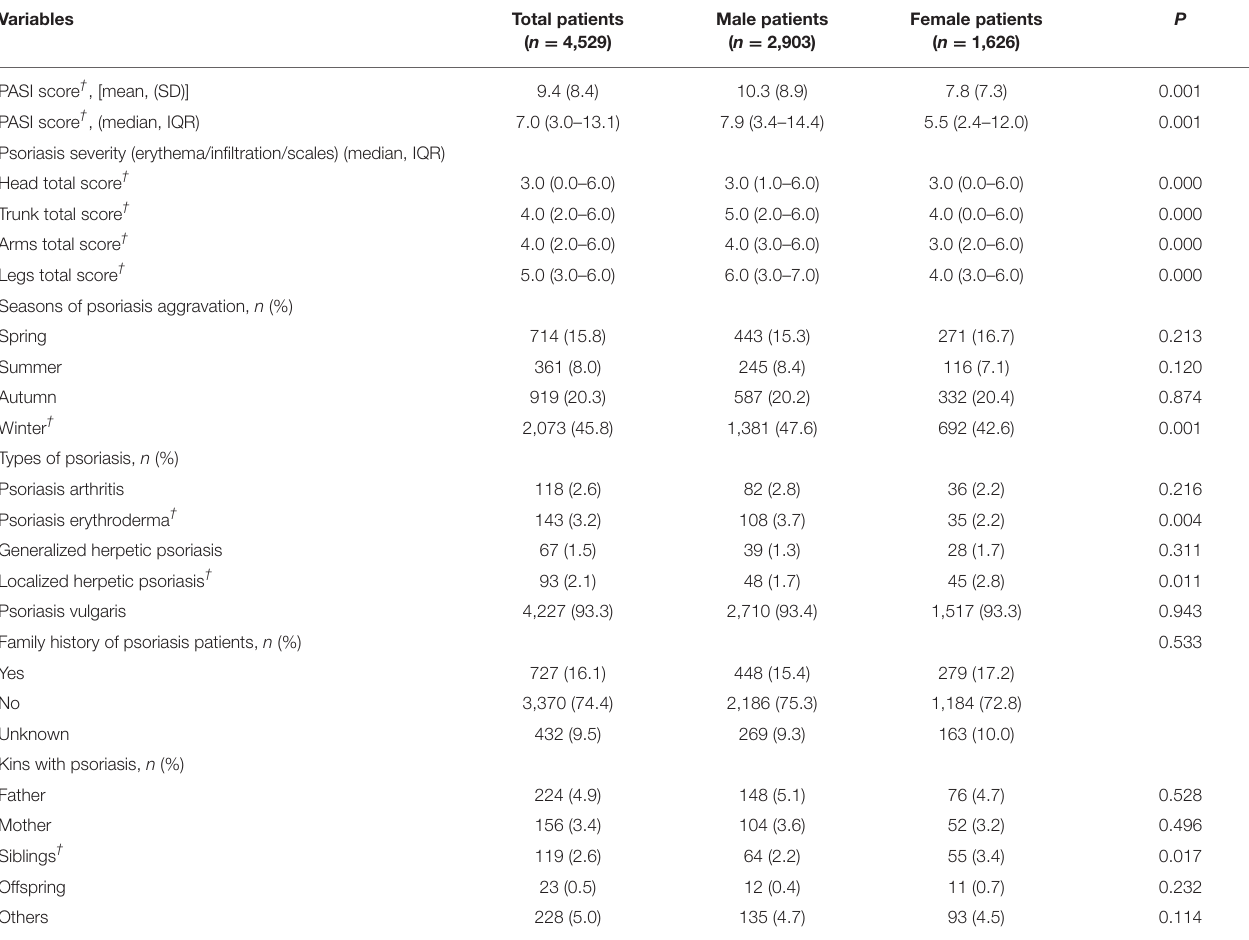
TABLE 3 | The psoriasis severity, family history, seasonality aggravation and skin damage condition among psoriasis patients in China, 2020–2021.